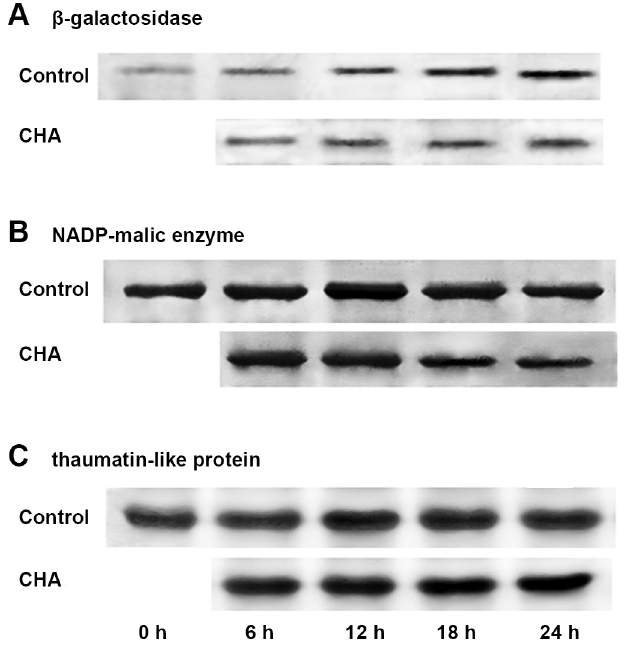
Fig 5. Western blot analysis of (A) galactosidase; (B) NADP-malic enzyme; and (C) thaumatin-like protein in apple pulp discs during incubation at 25°C.